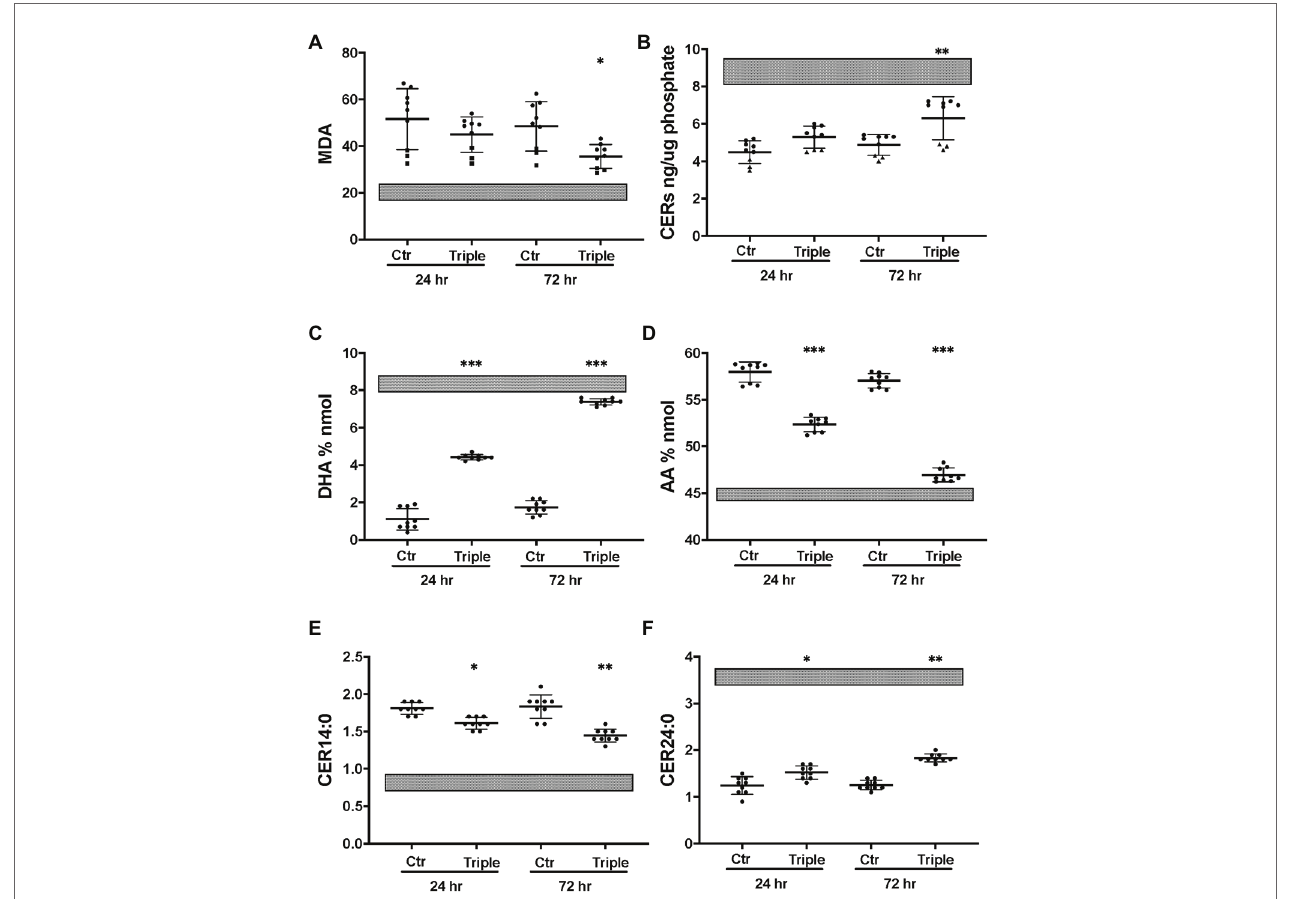
FIGURE 6 | Partial correction of oxidative stress and lipid imbalance in CF HBEC-ALI by elexacaftor/tezacaftor/ivacaftor triple therapy. CF HBEC ALI were treated for 24 or 72 h with the triple combination elexacaftor/tezacaftor/ivacaftor (VX-445 + VX-661 + VX-770; Triple) or vehicle alone (Ctr). CF HBEC ALI inserts of three donors, defined by their rescue by ivacaftor/lumacaftor and in Ussing chamber experiments Medium responder (BCF000191) low responder (BCF000554, squares) and high responder (BCF000584, triangles; Supplementary Table S1 ). Filters were analyzed in triplicate at every time point, data points ( N = 9) represent single inserts. Avarage Levels ± SEM are shown after treatment with elexacaftor/tezacaftor/ivacaftor or control vehicle (Ctr) for 24 or 72 h. Treatment of Non-CF HBEC in parallel with elexacaftor/tezacaftor/ivacaftor had no detectable effect at either timepoint (WP945, N = 6, not shown). For comparison, gray bars represent average ± SEM of parallel Non-CF data obtained in parallel (three donors, N = 12). (A) malondialdehyde (MDA) pmol/nmol fatty acid. (B) Total ceramides. (C) DHA levels (% nmol total fatty acids). (D) AA levels (% nmol total fatty acids). (E) Long chain ceramide (CER14:0). (F) Very long chain ceramide (CER24:0) both expressed as pmol/nmol phosphate. Most relevant comparisons are indicated (unpaired ANOVA, Dunnet, * P adj < 0.05, ** p < 0.01, *** p < 0.001, using parallel carrier treated control at 24 and 72 h, respectively, as